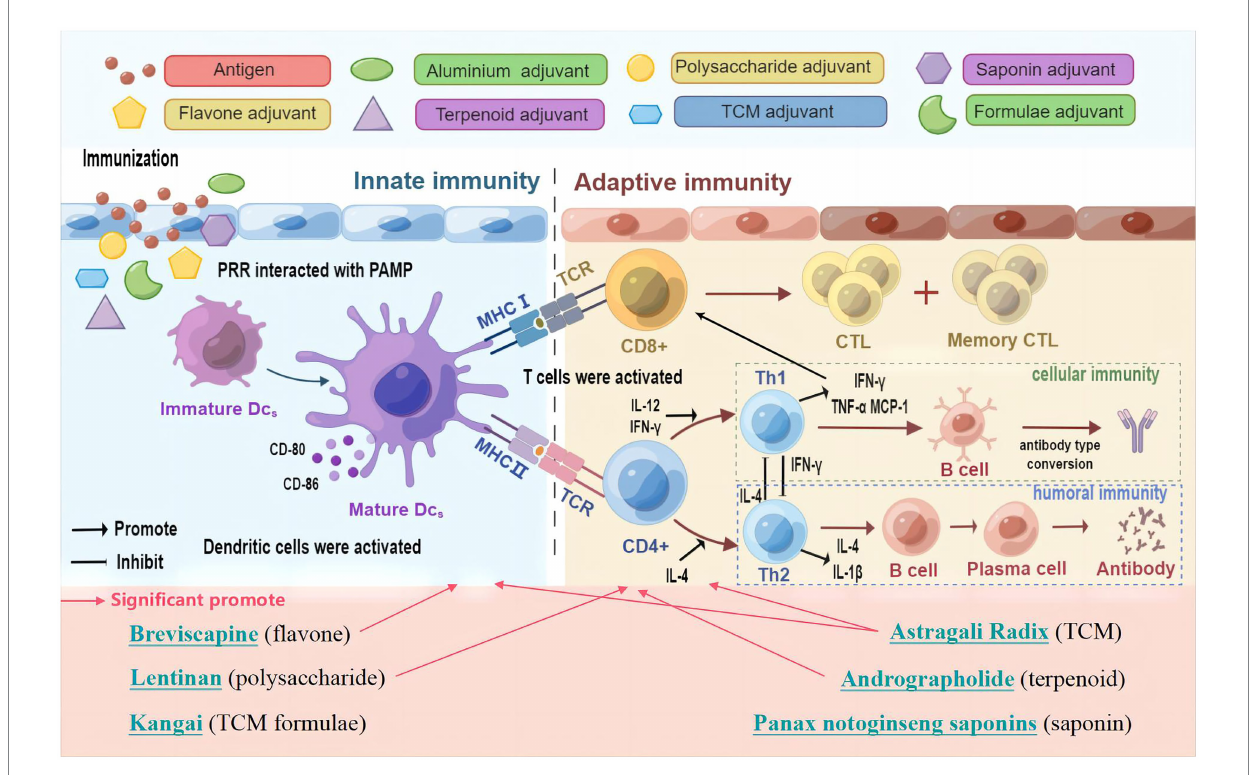
FIGURE 9 Schematic diagram of the mechanisms induced by TCM and its active ingredients to improve influenza vaccine immune responses. Figure drawn using